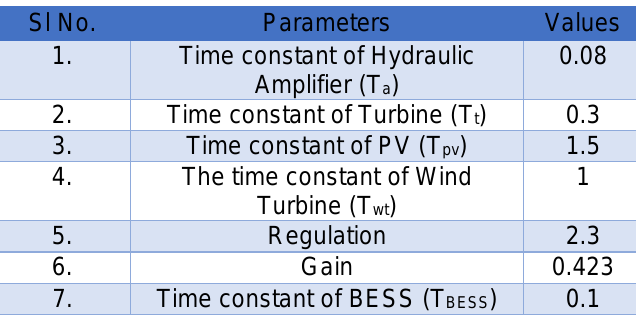
Table 2. Values of parameters used in the